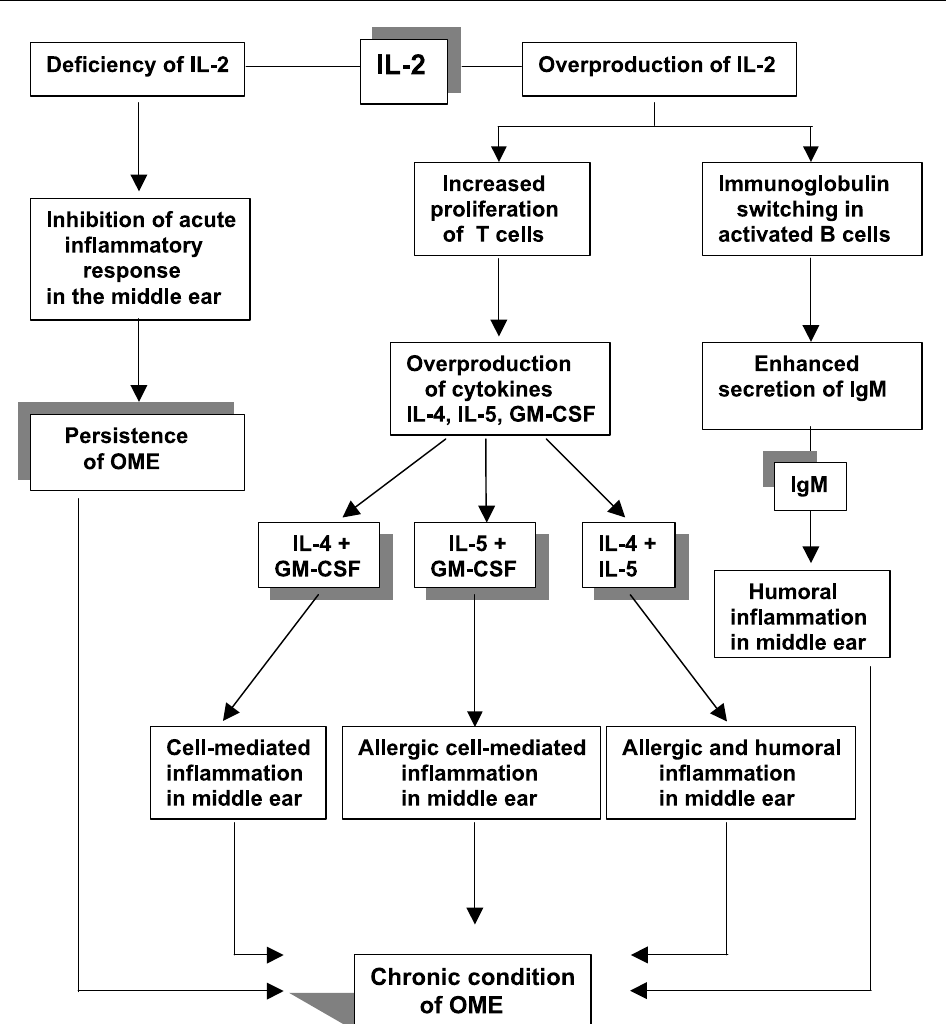
FIG. 3. Cellular and molecular consequences of the unbalanced production of IL-2 in the course of the middle ear inflammation leading to the chronic condition of